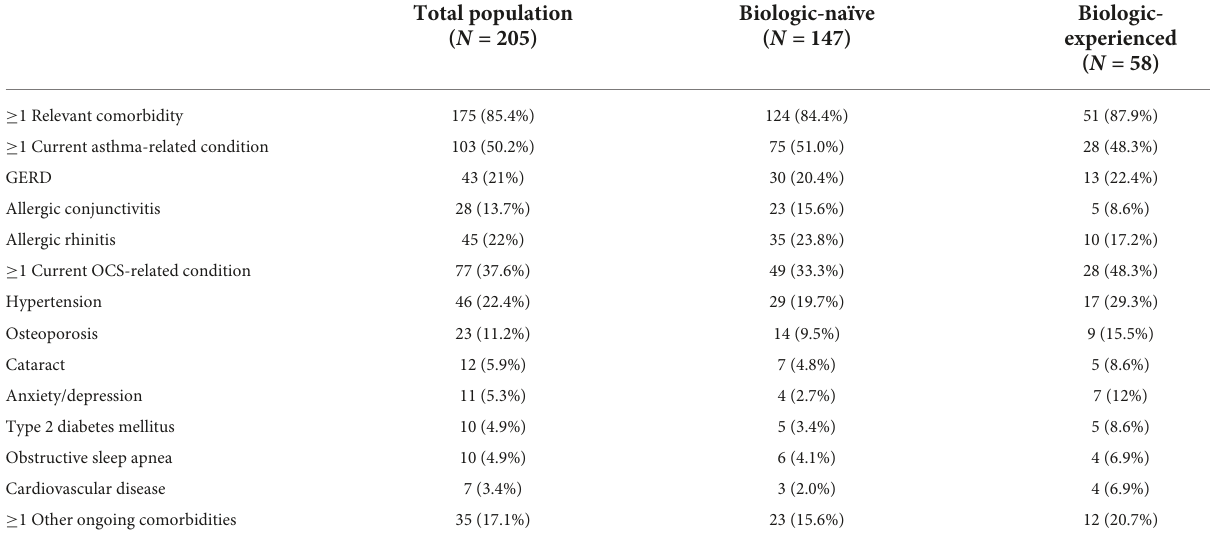
TABLE 2 List and percentage of comorbidities within the study